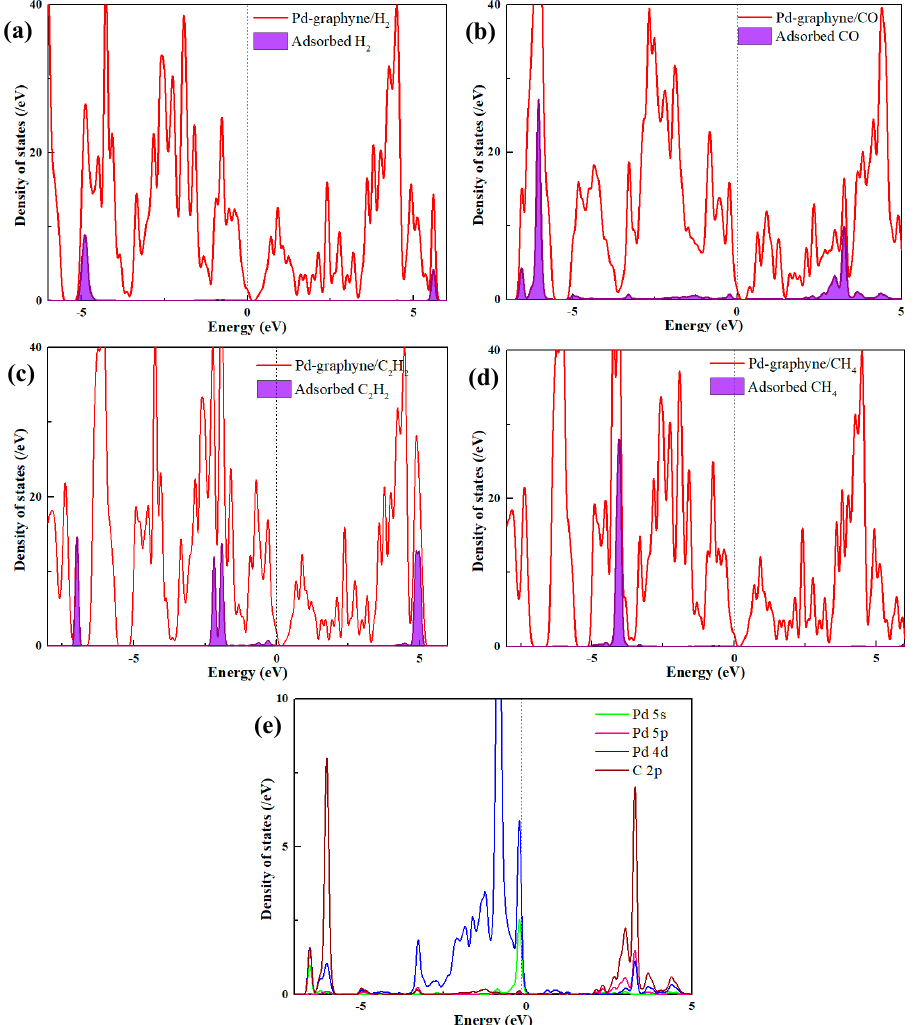
Figure 7. TDOS and PDOS of ( a ) Pd-graphyne / H 2 ; ( b ) Pd-graphyne / CO; ( c ) Pd-graphyne / C 2 H 2 ; ( d ) Pd-graphyne / CH 4 ; and ( e ) atomic orbitals of CO adsorption.